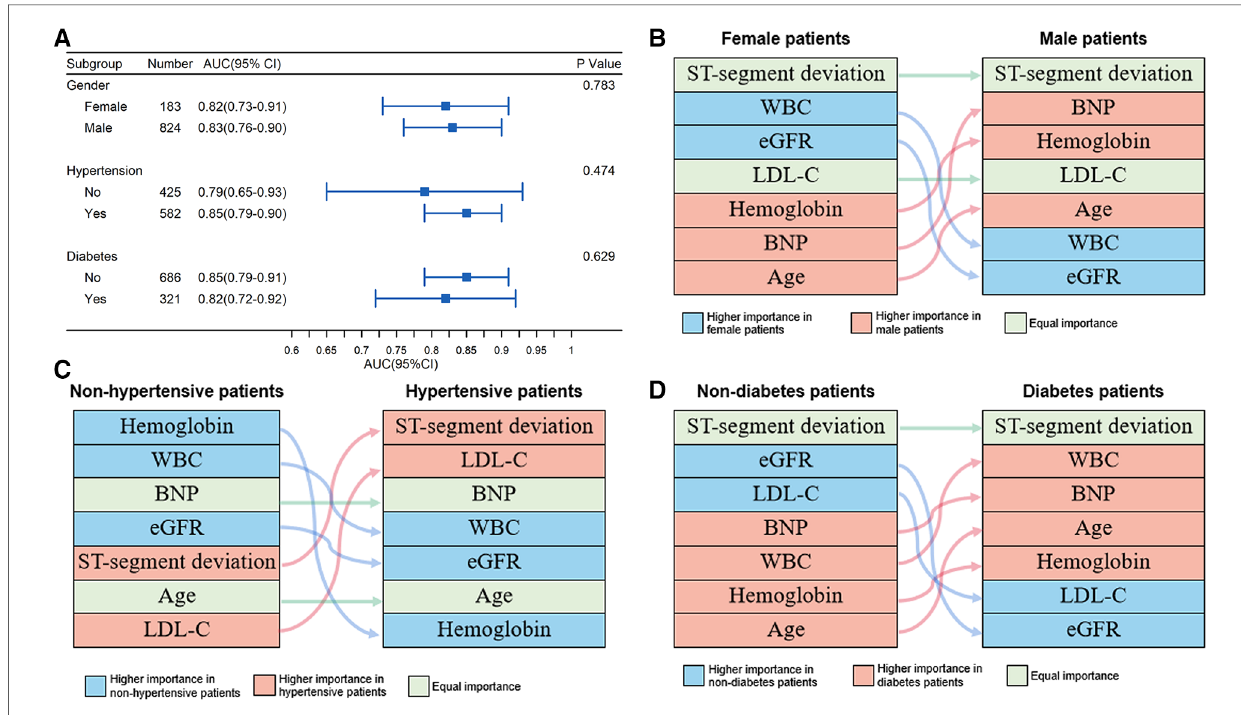
FIGURE 4 Performance and relative importance of variables in subgroups. ( A ) Forest plot for AUC and 95% con fi dence interval depicting overall discriminative ef fi cacy of the iPROMPT score across pre-determined subgroups; ( B – D ) Alluvial plot of predictors for prognosis prediction identi fi ed by variables ’ contribution in sex ( B ), hypertensive ( C ) and diabetic subgroup ( D ). AUC, area under the curve; BNP, B-type natriuretic peptide; eGFR, estimate glomerular fi ltration rate; WBC, white blood cell